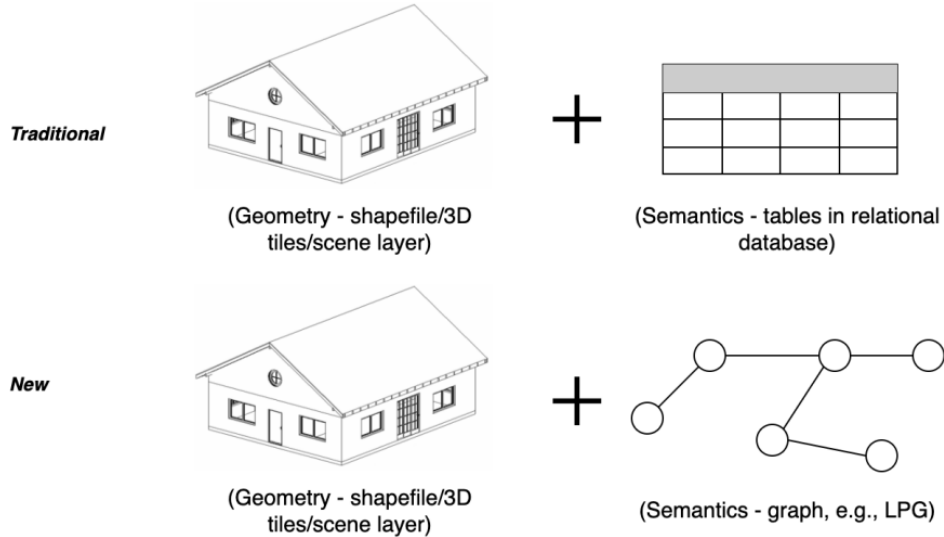
Figure 2. A new form of using building information in GIS by using graph.